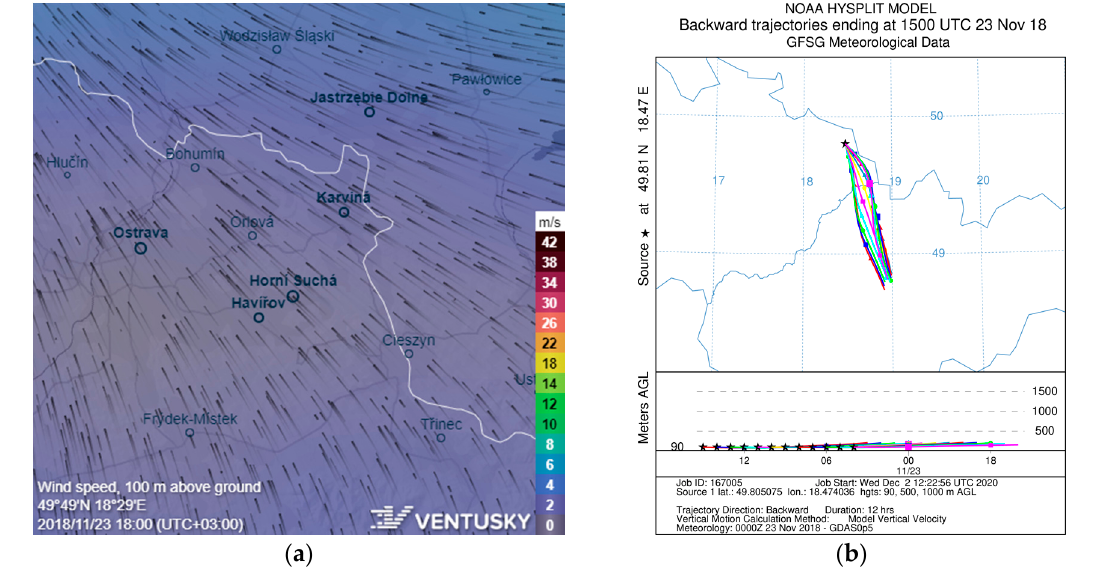
Figure 9. The modelled wind fields ( a ) and backward trajectories ( b ) for the smog situations in November 2018 [48,50,51].